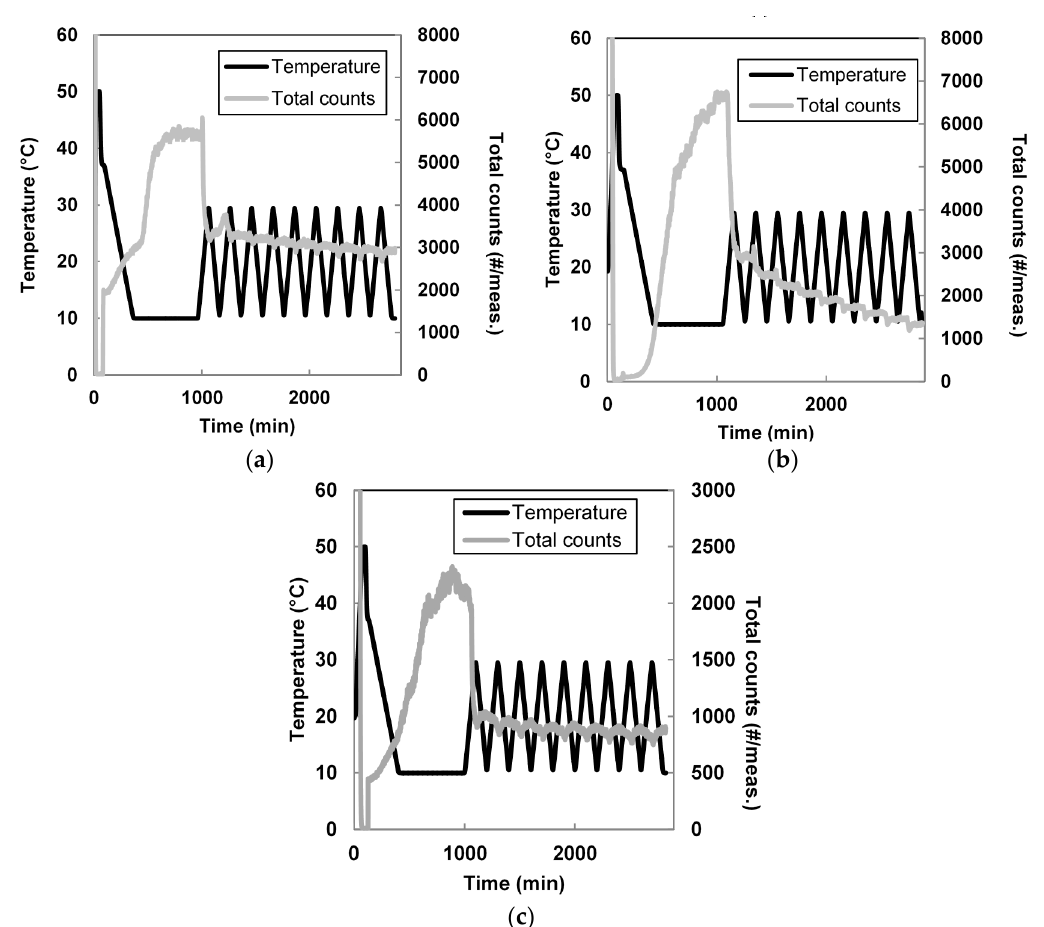
Figure 8. ( a ) Total counts and temperature profile for the seeded experiment with 6% membrane seeds; ( b ) 2% antisolvent addition seeds; ( c ) polymorphic transformation seeds.